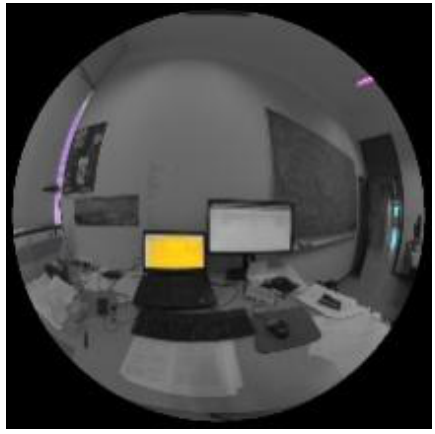
Figure 10. Glare source detection by evalglare factor 5 method for a visual scene of the field study.